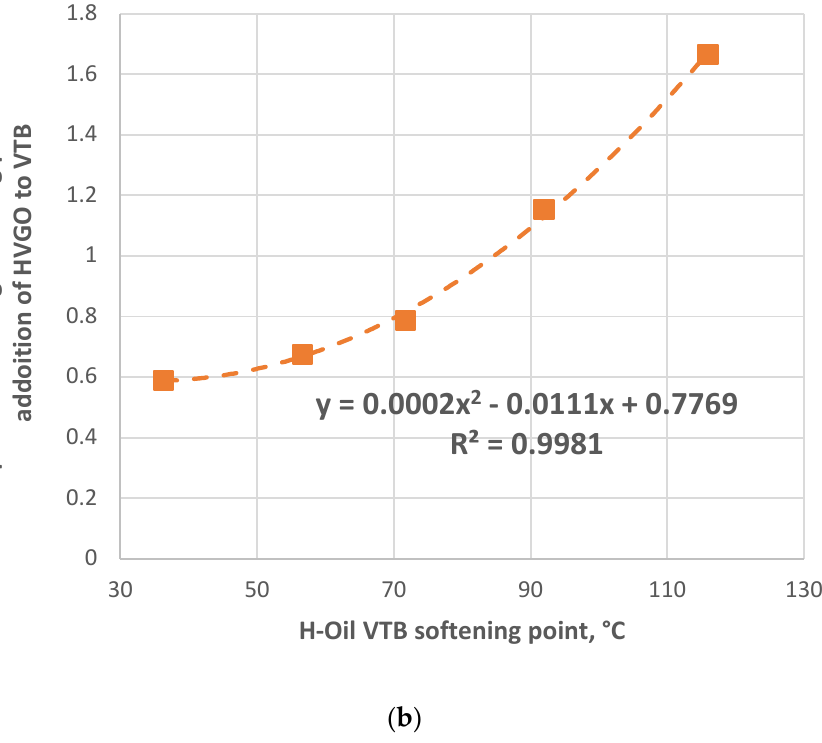
Figure 6. Variation of H-Oil ® VTB softening point with increasing of HVGO content in the blend VTB-HVGO ( a ), and dependence of the slope of decreasing of the softening point of the blend VTB-HVGO on the softening point of the pure VTB ( b ).